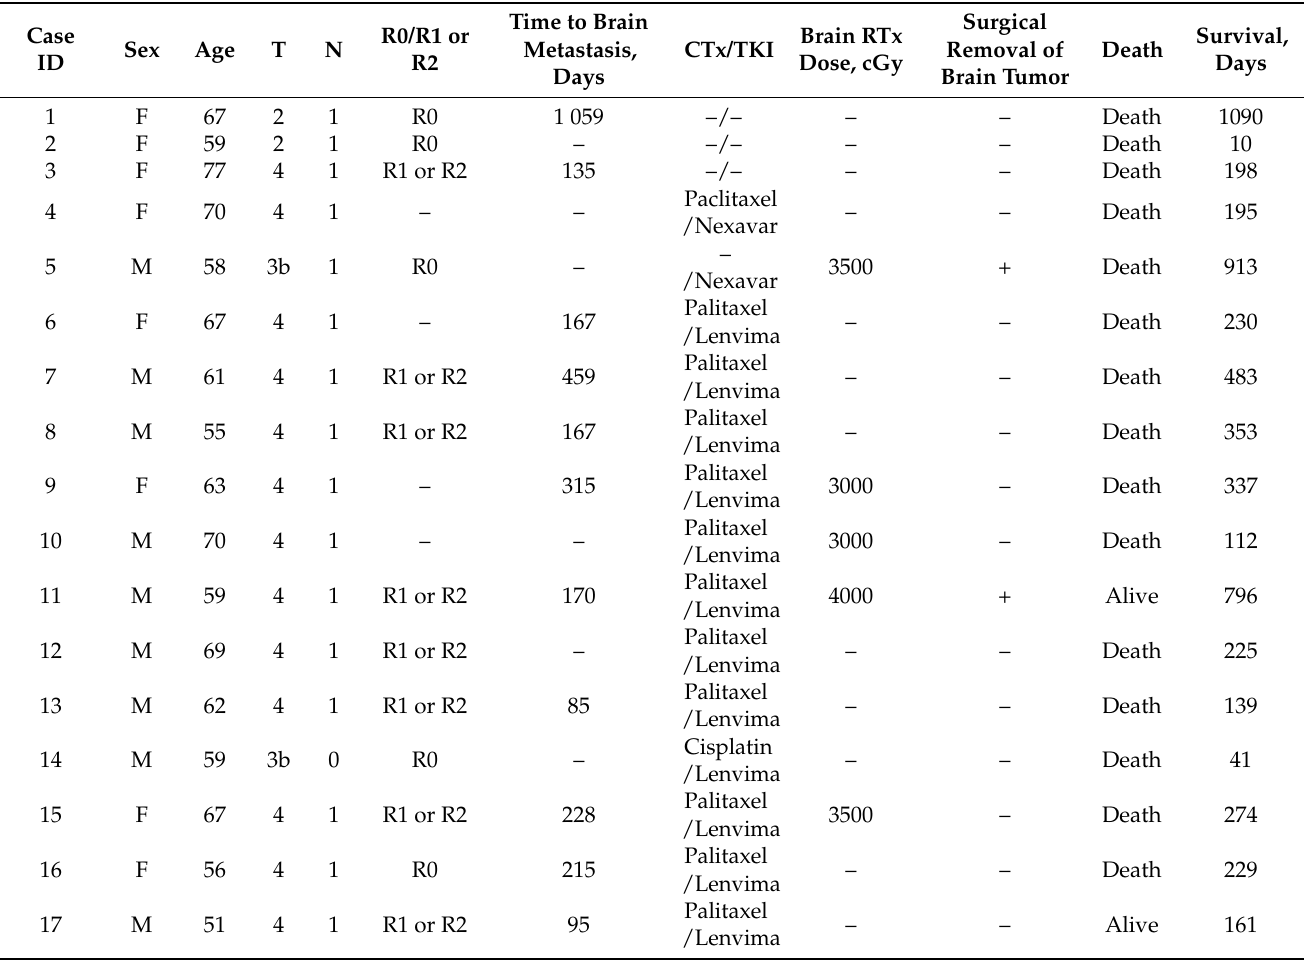
Table 4. Clinical features and overall survival of patients with anaplastic thyroid cancer and brain